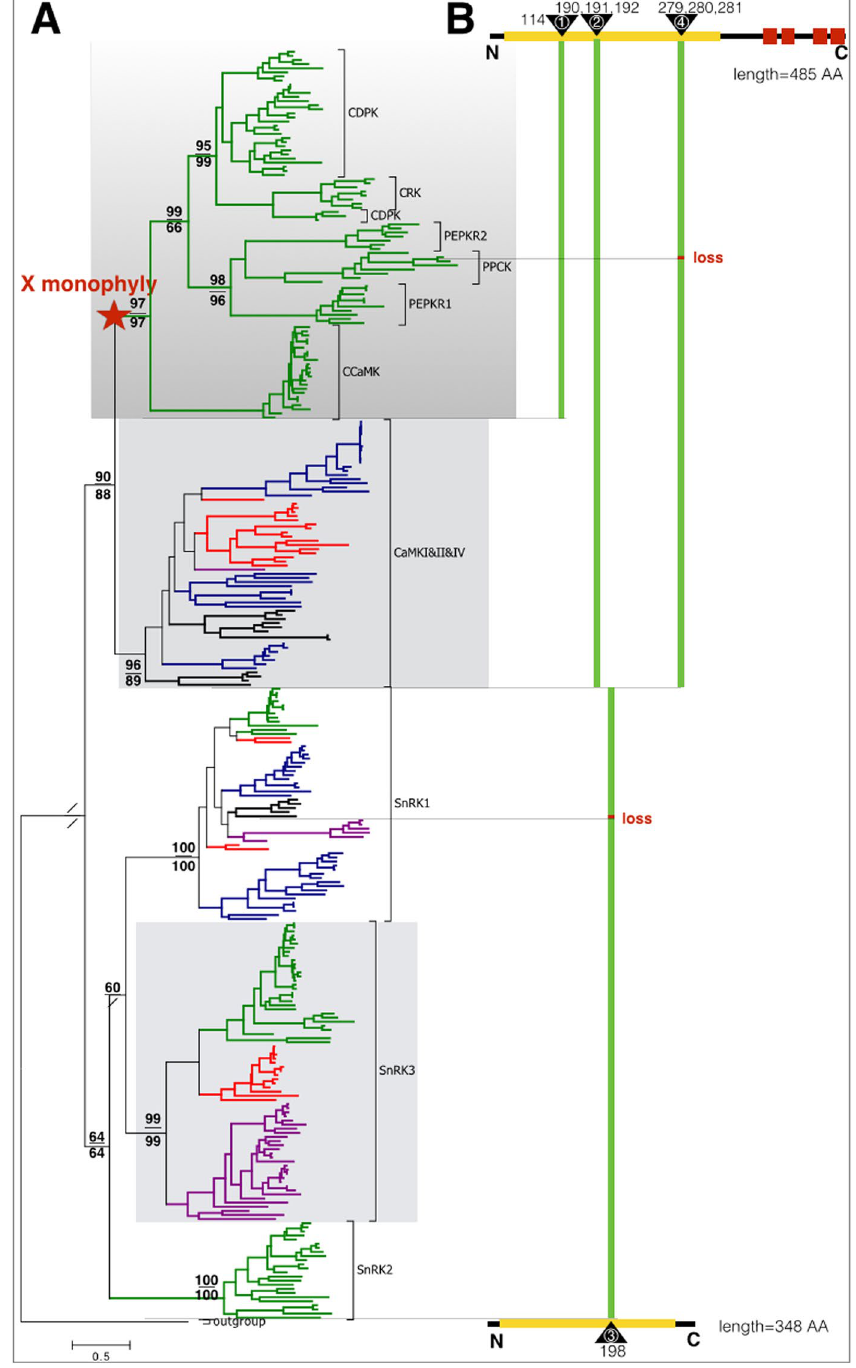
Figure 1. Three monophylic clusters identified among eukaryotic Ca 2 + activated protein kinases. ( A ) The rooted tree displaying three monophylies of Ca 2 + activated protein kinases among the eukaryotes. Mitogen- activated protein kinase (MAPK) was the outgroup. Major nodes were shown with two supporting values: maximum-likelihood by FastTree (upper number), randomized axelerated maximum likelihood methods (lower number). Branches are colored to represent different origins, Green: Archaeplastida, blue: Opisthokonta, red: SAR, black: Amoebozoa, purple: Excavata. ( B ) Schematic representation of monophylic cluster specific structural features with the schematic structures from the first and the last branch. Yellow block: kinase domain, red block: EF hand, green bar: monophyly specific inserted amino acid